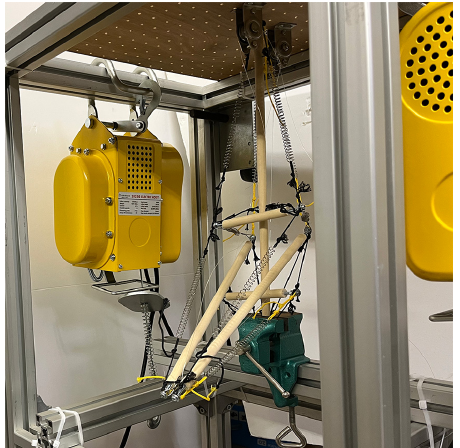
Figure 22. The tip of the lower arm is controlled downward by the electric